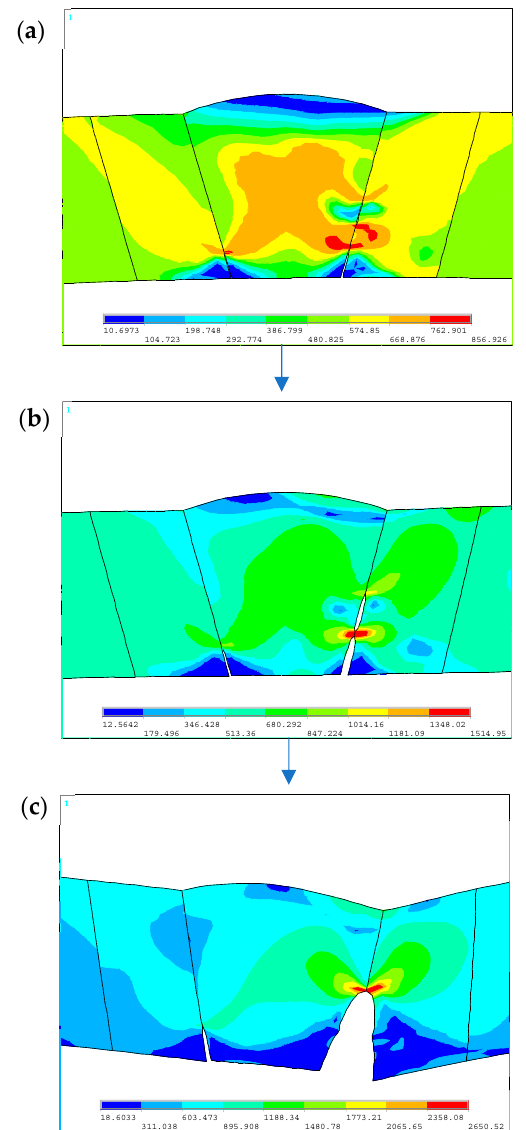
Figure 3. Von-Mises stress patterns of crack propagation process. ( a ) The starting expansion of tip 1 of the main crack, ( b ) the main crack contacting the auxiliary crack, ( c ) the main crack merging with the auxiliary crack.